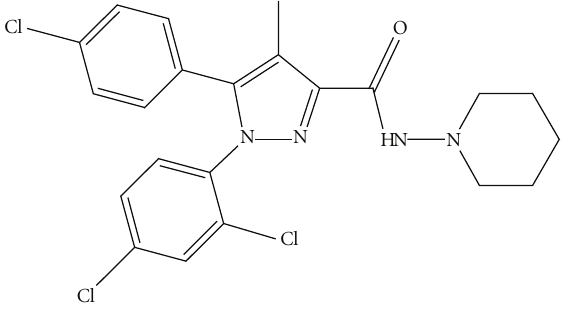
Figure 1: Structure of rimonabant. Figure 2: Chromatogram of blank plasma.